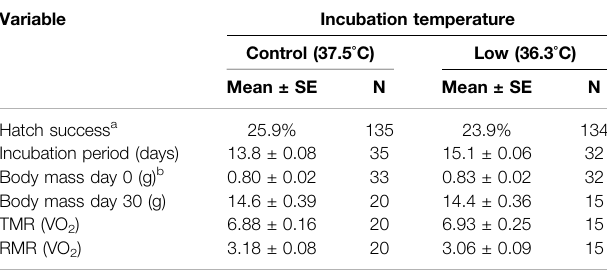
TABLE 1 | Summary statistics of hatch success, incubation period, body mass, and metabolic rate.